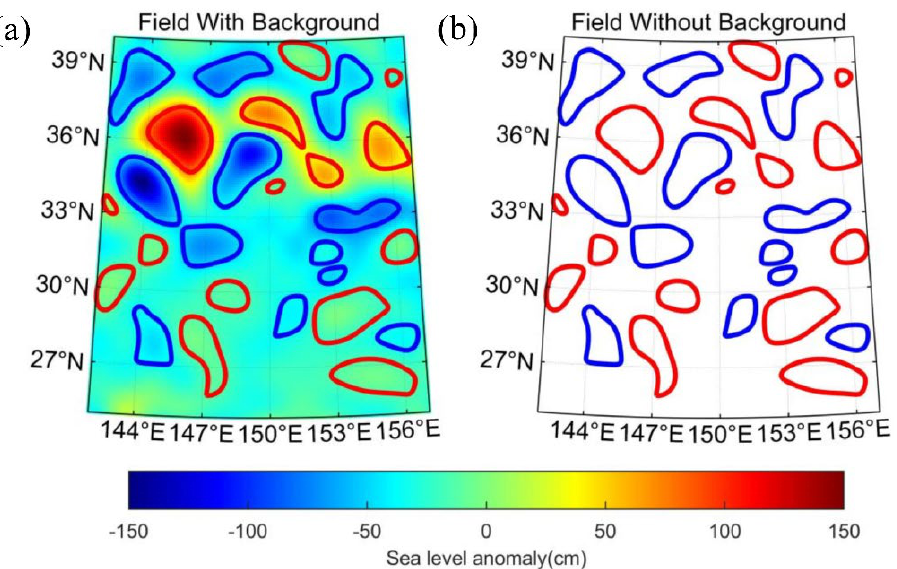
Figure 17. ( a ) Field with background, the red contour indicates anticyclone eddies, the blue contour indicates cyclone eddies. ( b ) Field without background, the red contour indicates anticyclone eddies, and the blue contour indicates cyclone eddies.